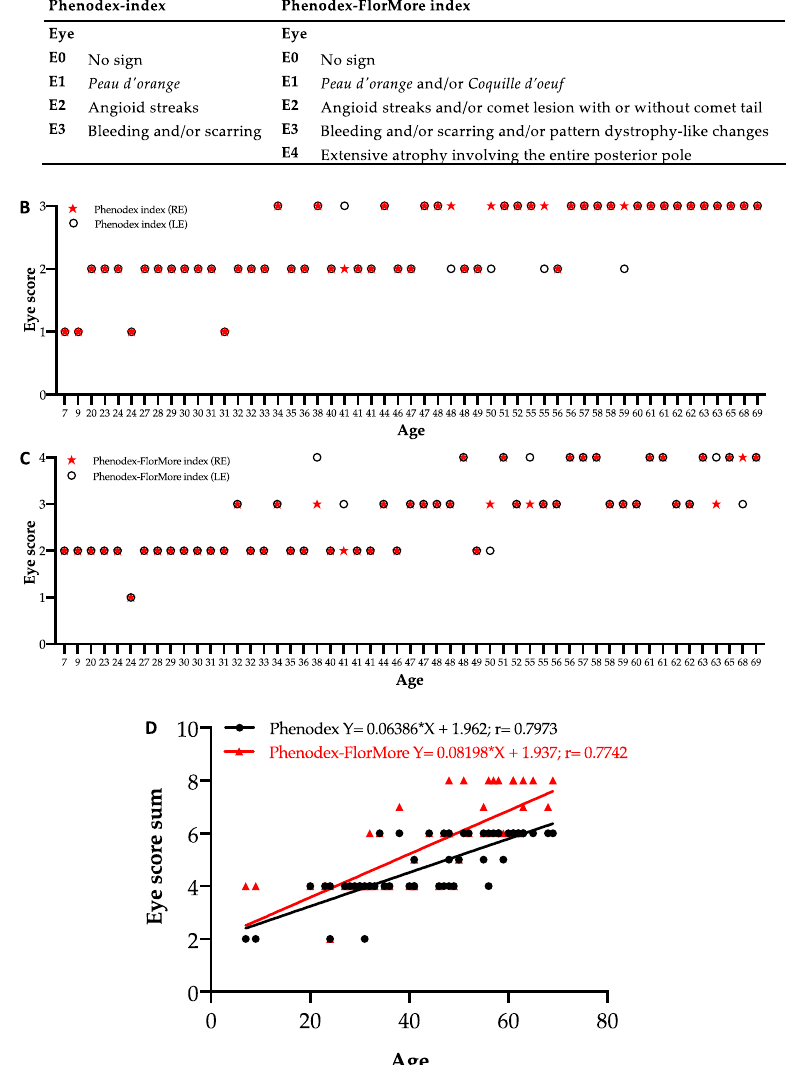
Figure 7. ( A ) Eye score according to the Phenodex or Phenodex-FlorMore index, respectively. ( B , C ) Graphs show the right (RE) and left (LE) eye score of each patient according to the Phenodex or Phenodex-FlorMore index, respectively. ( D ) Scatter diagrams and linear regression analysis of the sum of eye scores in PXE patients according to the Phenodex and Phenodex-FlorMore index.